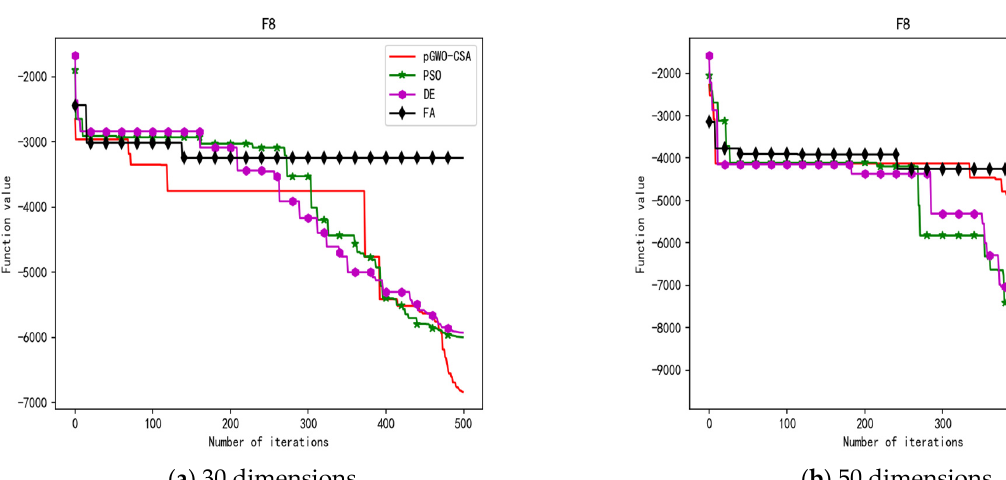
Figure 26. Convergence curve of test function F7.